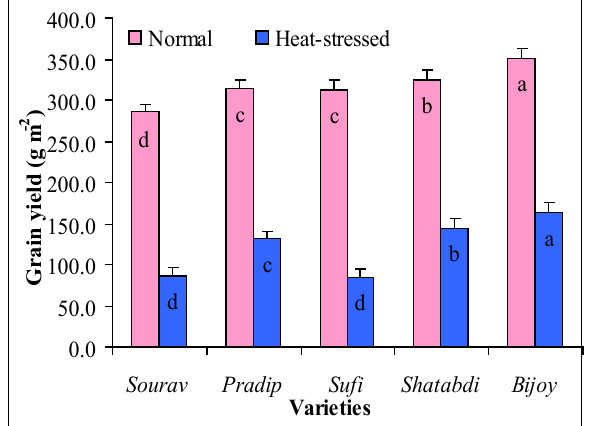
Fig. 6. Yield of different wheat varieties under normal and heat stressed condition. Mean (±SD) was calculated from three rep- licates for each treatment. Bars with different letters are signifi- cantly different at P < 0.05 applying LSD